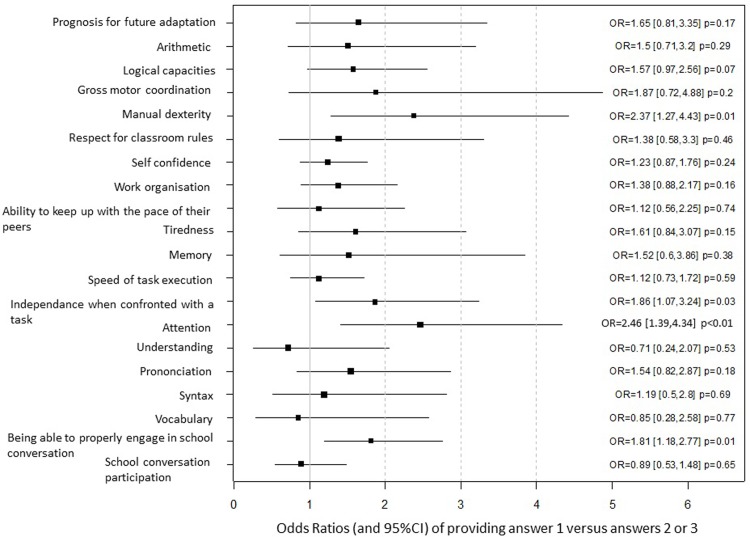
Increased risk of providing answer 1 (corresponding to the lowest score) versus Answers 2 or 3 for each item of the “Global School Adaptation” (GSA) questionnaire associated with parental separation that occurred between three and five years of age (n = 164), compared to children whose parents were still living together at five years (n = 2,439).Results were expressed as Odds Ratios (OR) with their 95% Confidence Intervals (CI).